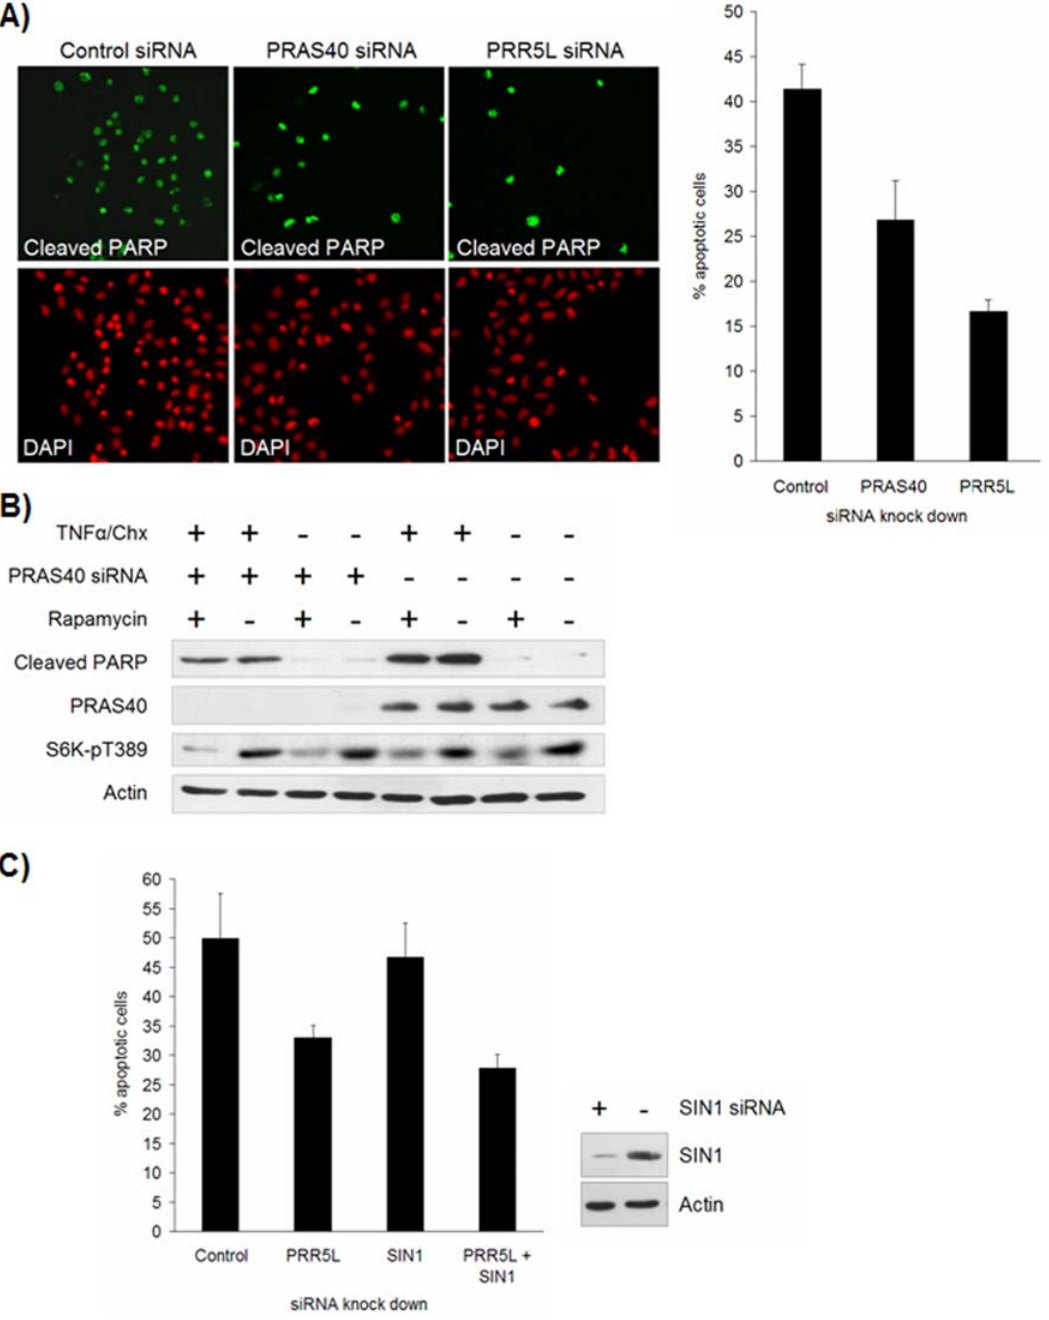
Figure 4. PRAS40 and PRR5L are pro-apoptotic. A. PRR5L and PRAS40 knock down cells are resistant to TNF a /cycloheximide induced apoptosis. HeLa cells were transfected with PRR5L, PRAS40 or control siRNA and incubated for 48 h, followed by 2 h induction of apoptosis with TNF a and cycloheximide. Cells were fixed and stained with DAPI and cleaved PARP antibody, and the percentage of apoptotic cells was quantified. B. PRAS40’s effect on apoptosis is independent of mTORC1. HeLa cells were transfected with PRAS40 or control siRNA and incubated for 48 h, and treated with 100 nM rapamycin or carrier for 1 h before incubation with TNF a and cycloheximide for 2 h to induce apoptosis. Extracts were analyzed by immunoblotting with the indicated antibodies. C. PRR5L deficiency protects against apoptosis in SIN1 deficient cells. HeLa cells were transfected with diced PRR5L siRNA and/or synthetic siRNA against SIN1 as indicated, or the appropriate control siRNAs. Cells were incubated for 48 h, and apoptosis was induced with TNF a and cycloheximide for 2 h. Cells were fixed and stained with DAPI and cleaved PARP antibody, and the percentage of apoptotic cells was quantified. The efficiency of SIN1 knock down was assessed in parallel by immunoblotting (right panel).